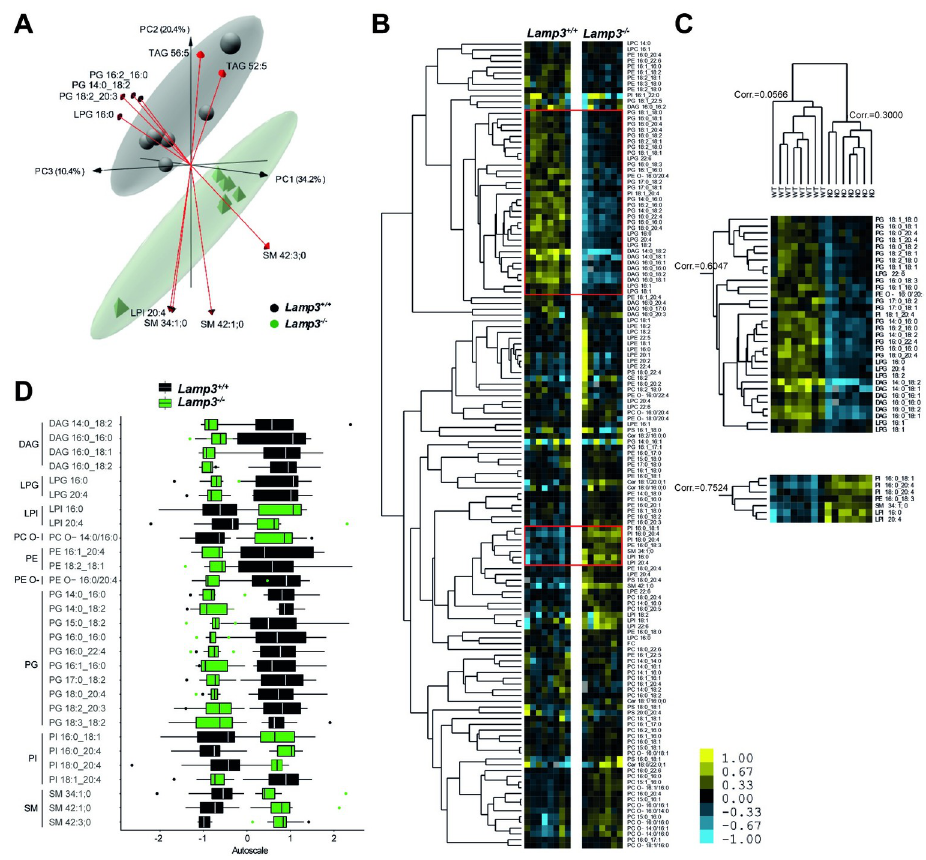
Fig 3. Deficiency of LAMP3 results in minor changes in the BAL lipidome under basal conditions. (A) Three- dimensional principal component analysis (PCA) loadings plot of the BAL lipidome of wild type (black) and Lamp3 -/- (green) mice. Each point represents one individual animal. Arrows show the 10 lipid species with the strongest effect across all principal components. Ellipses show the 95% confidence interval of the group. PC1 to PC3 explain 65% of the variability in the data set. (B) Hierarchical clustering of 140 lipid species (of 208 after application of a 90% occupation threshold) identified in eight wild type and seven Lamp3 -/- mice BAL fluid samples. Each row represents a lipid species and each column a sample. Red boxes indicate enlarged selections (C2) and (C3). (C1) The hierarchical clustered tree of sample groups correlates both groups into two major branches. (C2) The Upper selected segment of the HCA with 31 lipids shown with a relative decrease to wildtype mice. (C3) The lower selected segment of the HCA was shown with a relative increase of 7 lipids to the control. (D) Differences in the BAL lipidome of wild type and Lamp3 -/- mice mutant using autoscaled ranges. Samples are color-coded according to their group, black for Lamp3 +/ + and green for Lamp3 -/- mice. Boxplots show the median with the interquartile range. Whiskers show maximum and minimum with outliers in the respective colors. Data is on the basis of mole percentage. Only lipid species are shown with a significant difference computed with a two-way ANOVA.